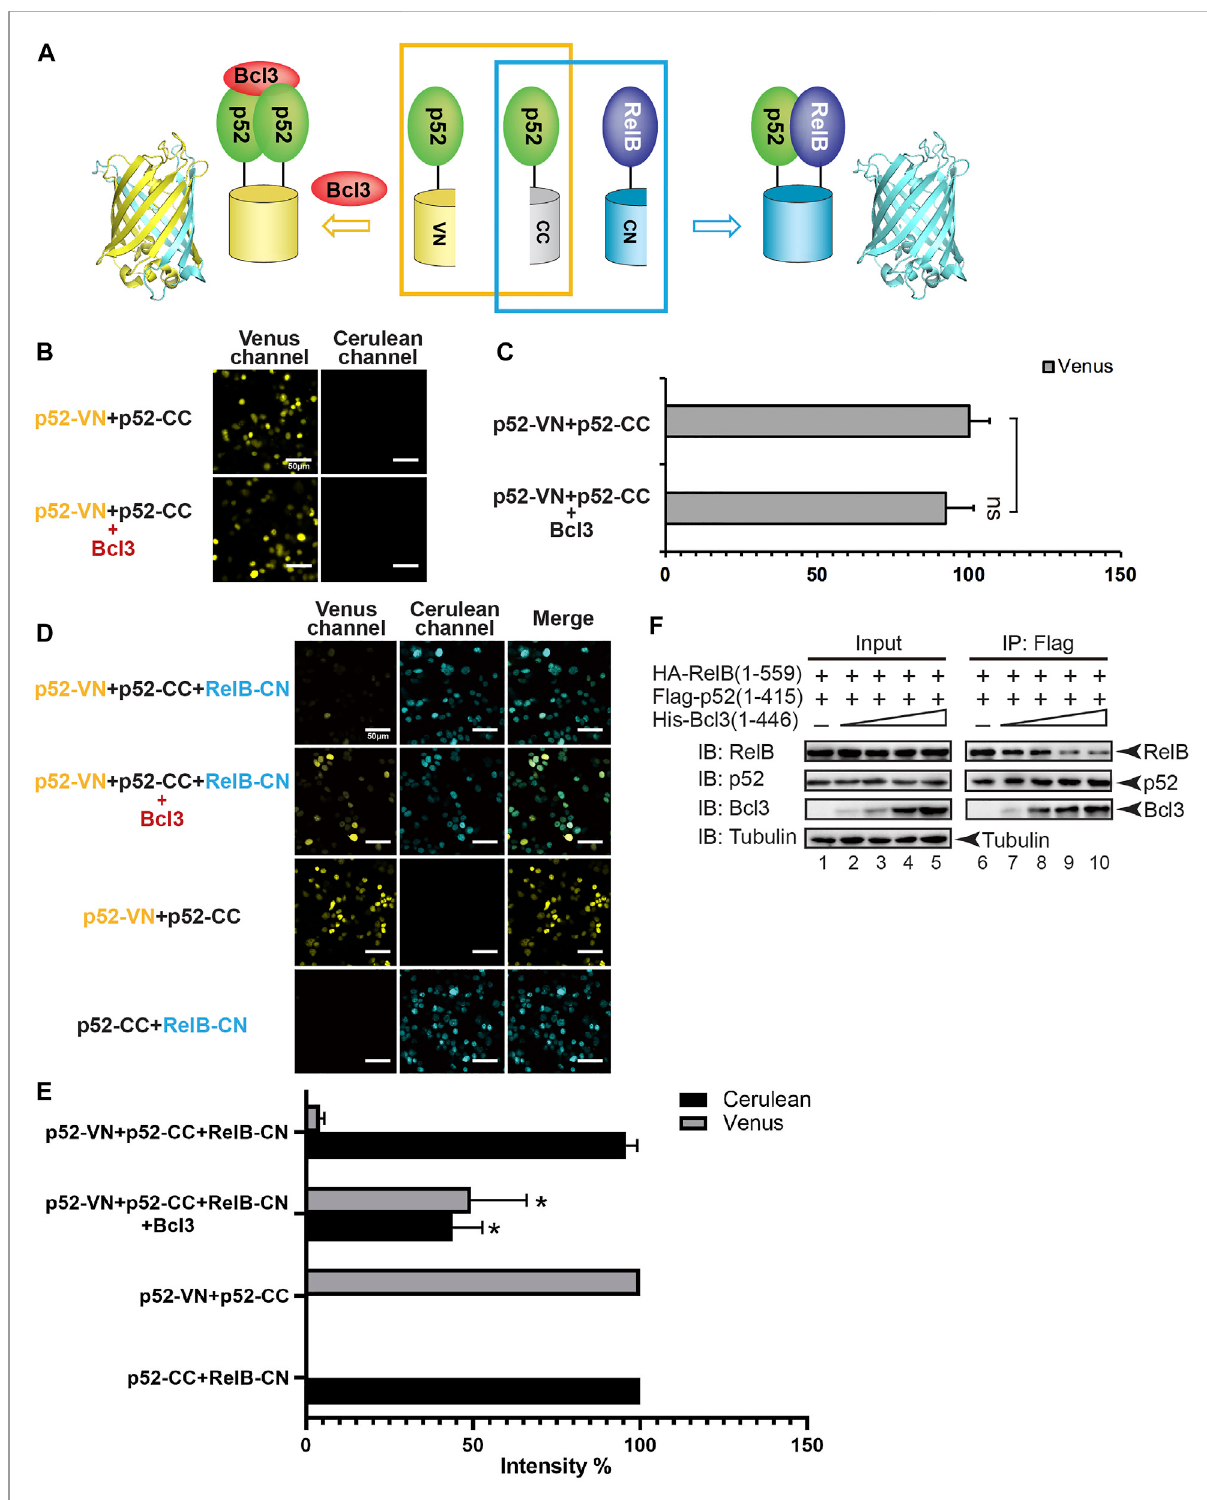
FIGURE 2 Bcl3 enhances the generation of the p52:p52 homodimer: p52:p52 vs. p52:RelB. (A) Diagram illustrating the principle of the multicolor BiFC assay. The p52:p52 homodimer formation brings VN and CN together to form a fl uorescent protein which could be detected at the Venus channel; the p52:RelB heterodimer formation brings CC and CN together to form an intact Cerulean protein which could be detected using the Cerulean channel. (B) Fluorescent images with the co-expression of indicated plasmids. The addition of Bcl3 did not further enhance the fl uorescence